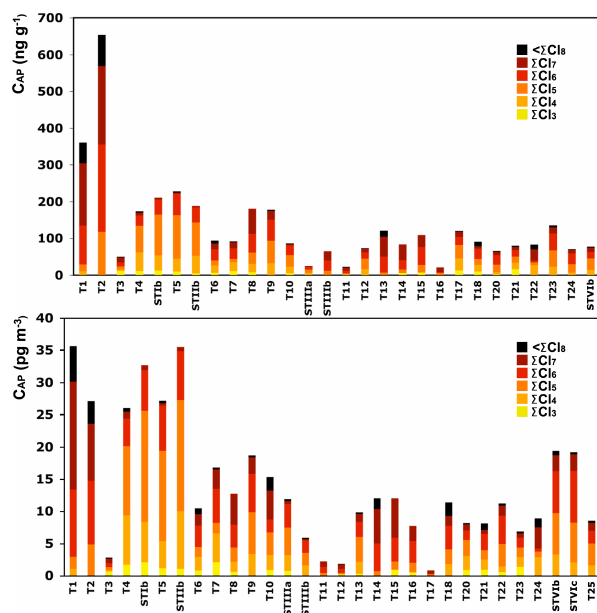
Figure 2. Spatial distribution of PCBs concentrations in the aerosol phase (pgm − 3 and pgm − 3 )